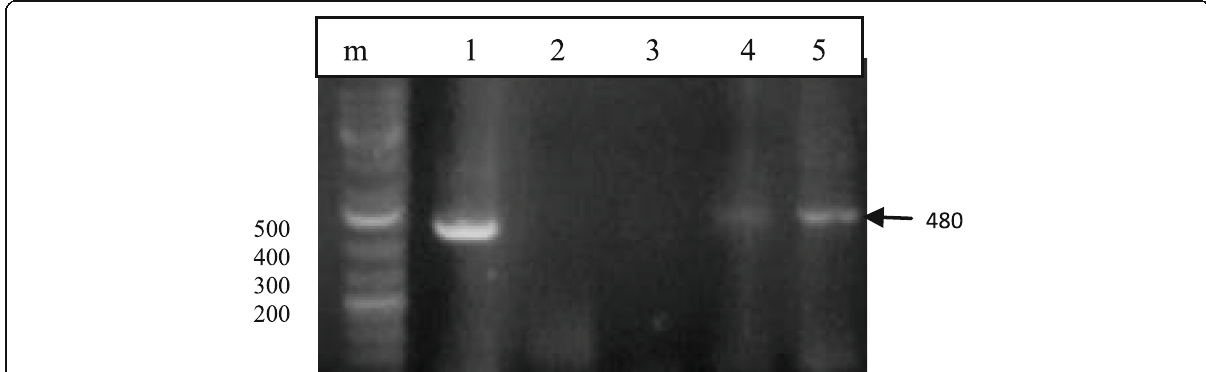
Fig. 1 Two percent agarose gel electrophoresis of PCR products of H. pylori 16s rRNA. Lane M: molecular weight marker (100 bp). Lanes 1, 4, and 5: positive DNA. Lanes 2 and 3: negative DNA samples. Arrow points to expected amplicon band size (480